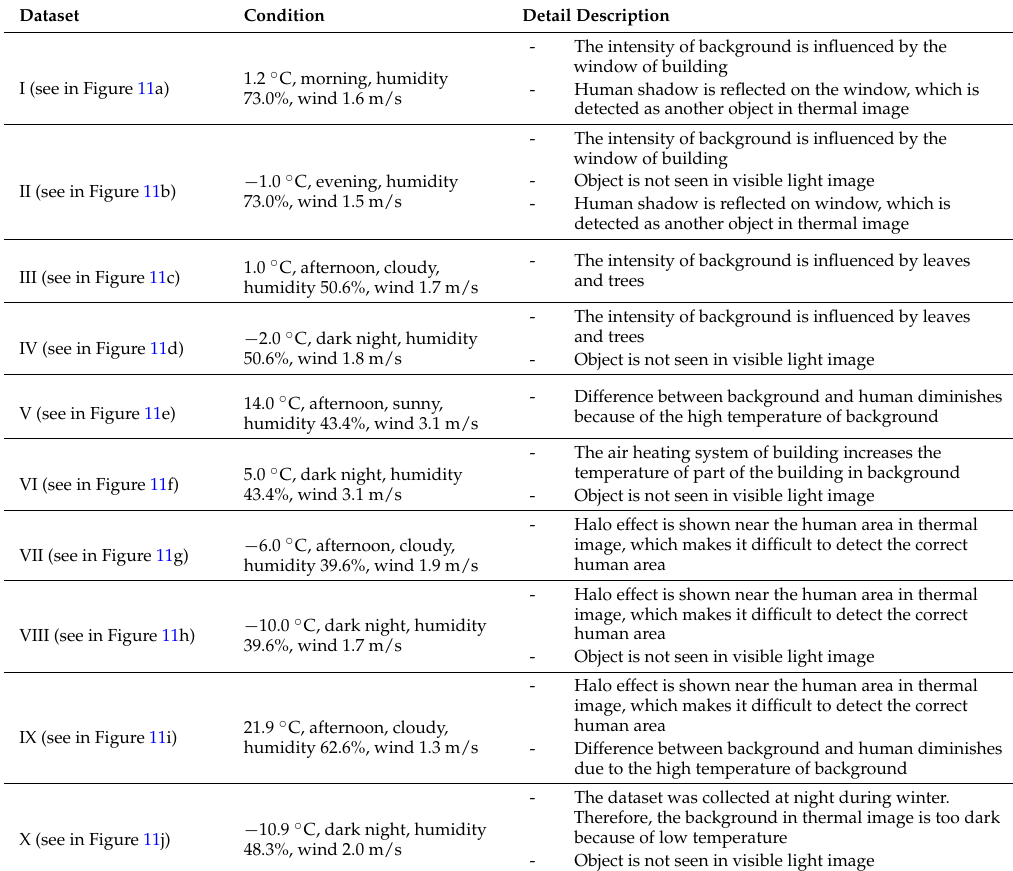
Table 2. Description of 12